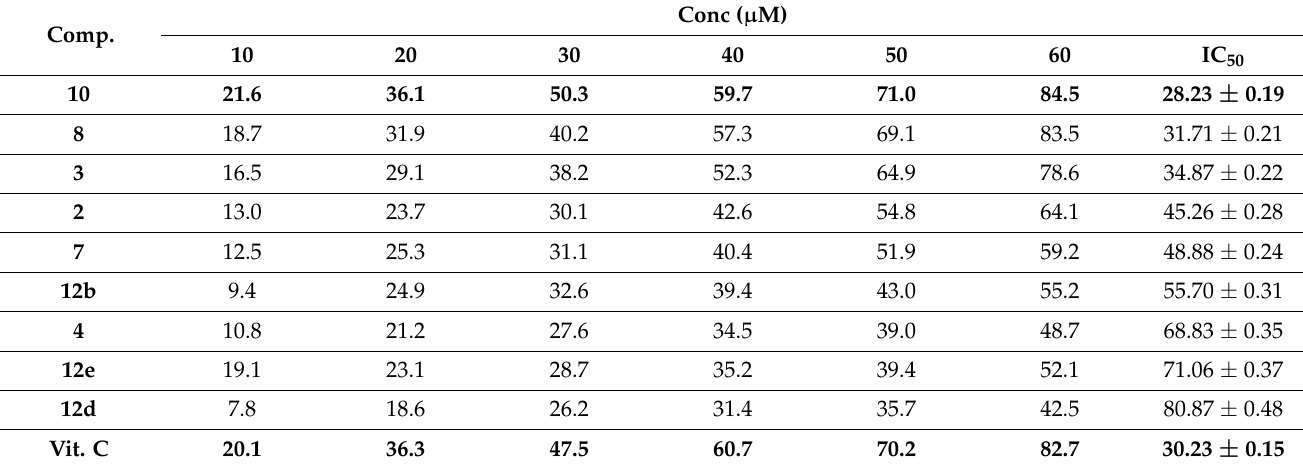
Table 1. Antioxidant activities of the newly designed and synthesized indolyl derivatives. Comp.